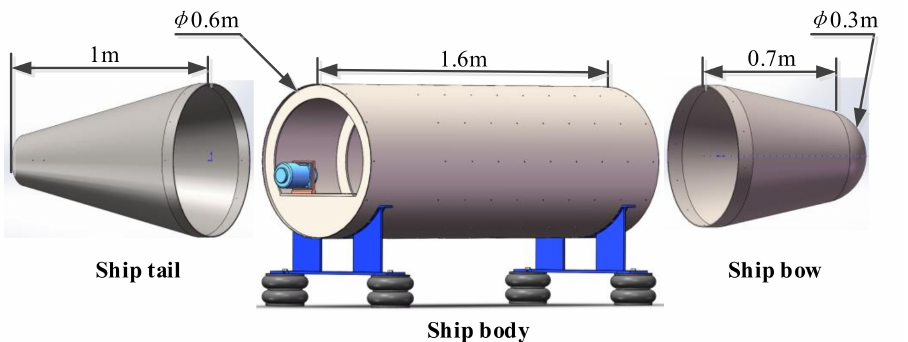
Figure 22. Structure of each part of the test